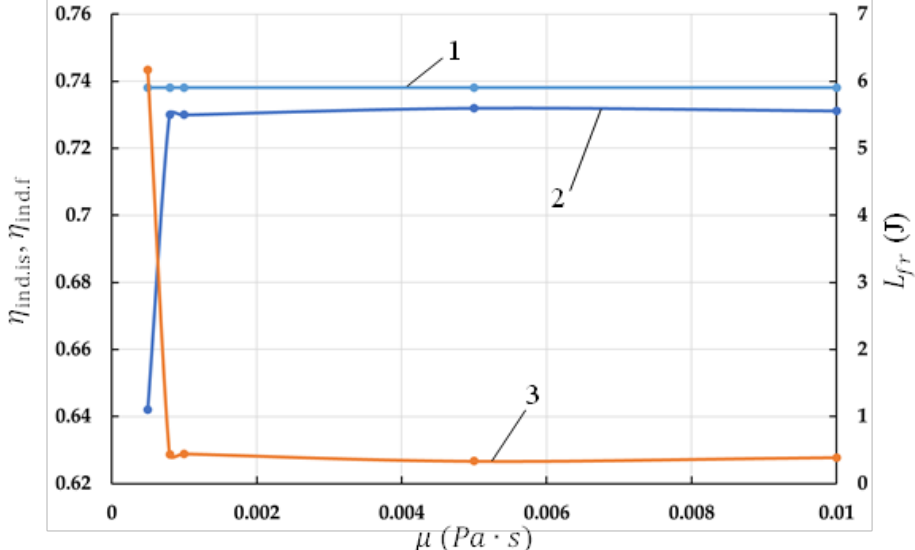
Figure 11. Dependence of indicator isothermal efficiency, total indicator efficiency and work of fric- tion forces on the dynamic viscosity coefficient (1- 𝜂 ind.is ; 2- 𝜂 ind.f ; 3- 𝐿 𝑓𝑟 ).